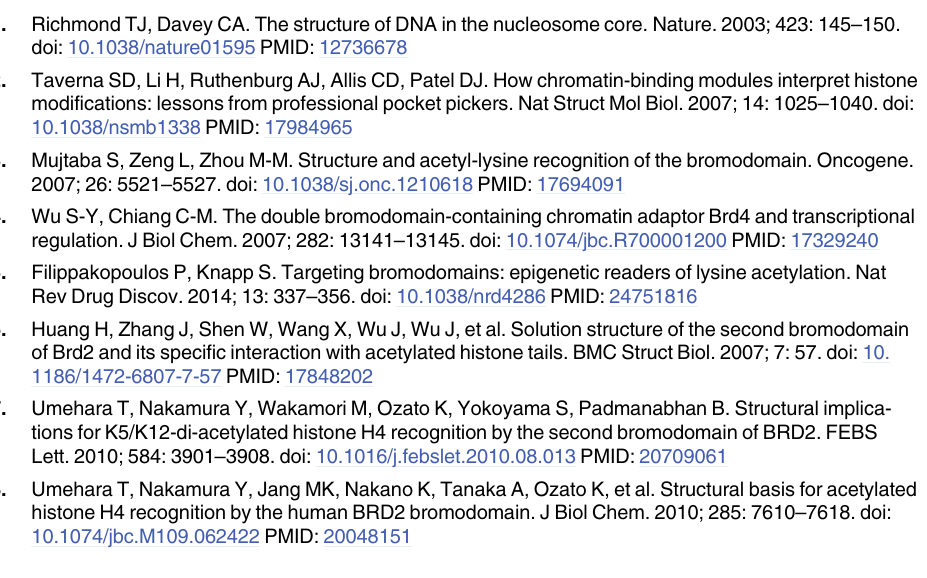
S1 Table. Docking energy analysis of top hits obtained from docking of BRD2-BD2 with NCI diversity III. S2 Table. RMSD values calculated between C α atoms of whole protein and active site resi- dues (ZA loop: residues 370 – 384, BC loop: residues 421 – 435) comparing